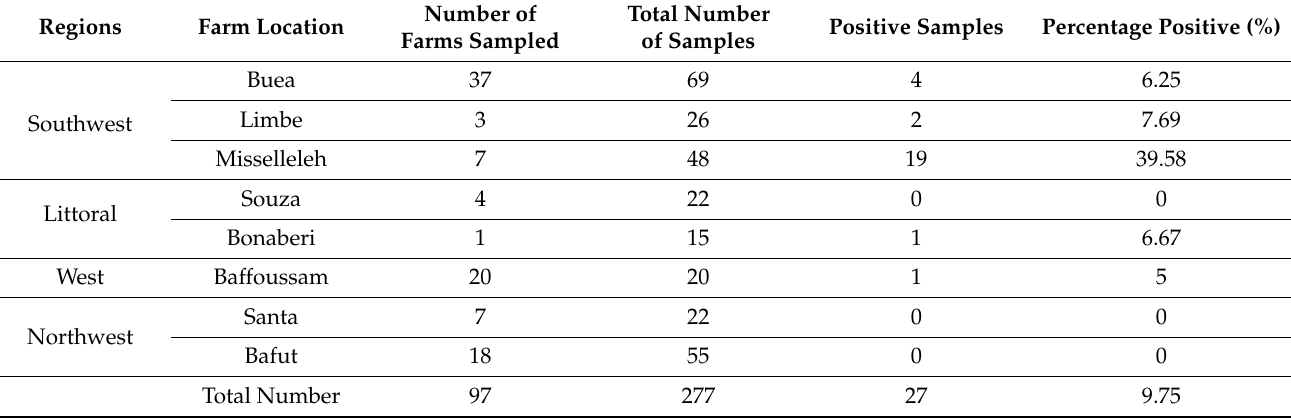
Table 2. ASFV carrier status per subdivision sampled.